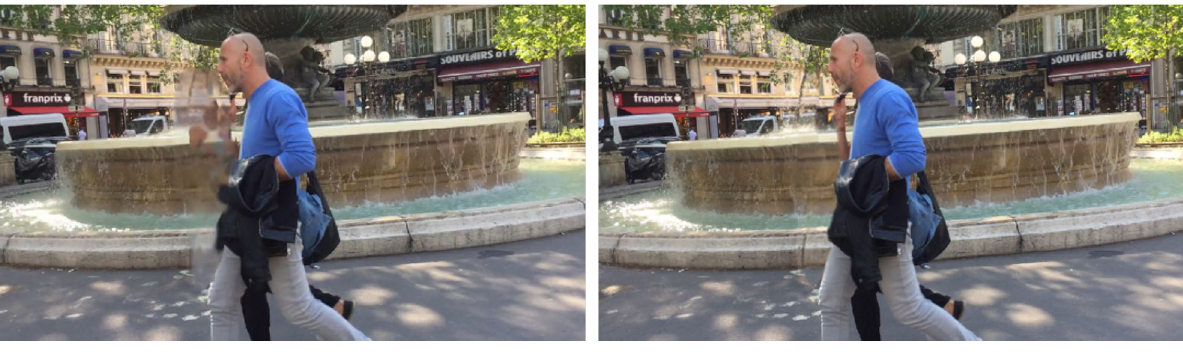
Fig. 14 Advantage of using segmentation masks to separate background and foreground. Left: without separation, the result has many artifacts. Right: the background and foreground are well reconstructed when reconstructed